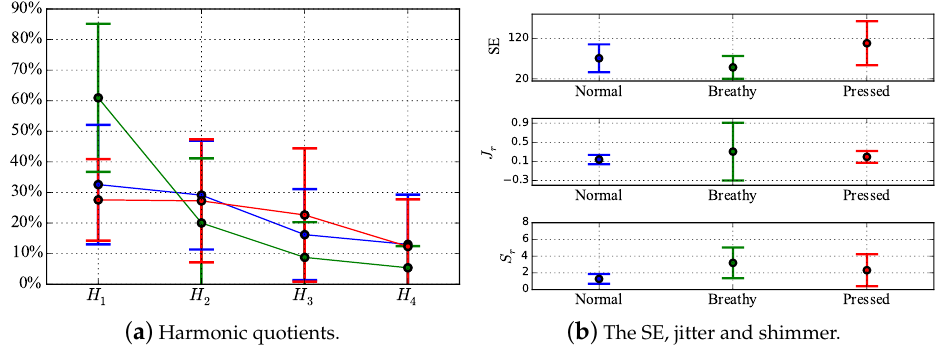
Figure 6. The averages and standard deviations of H 1 – H 4 , SE, jitter and shimmer based on 14 participants’ “pure” NSA samples for the pilot study. The blue, red and green colours represent the modal, pressed and breathy voice types,